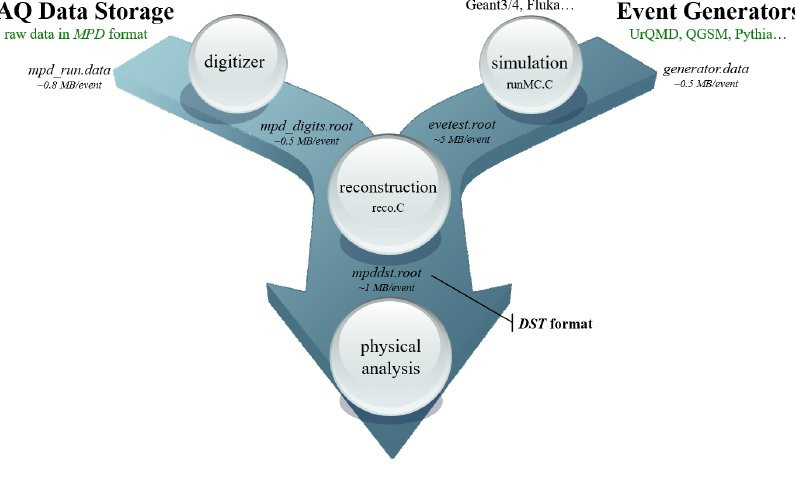
Figure 1. MpdRoot o ffl ine data processing